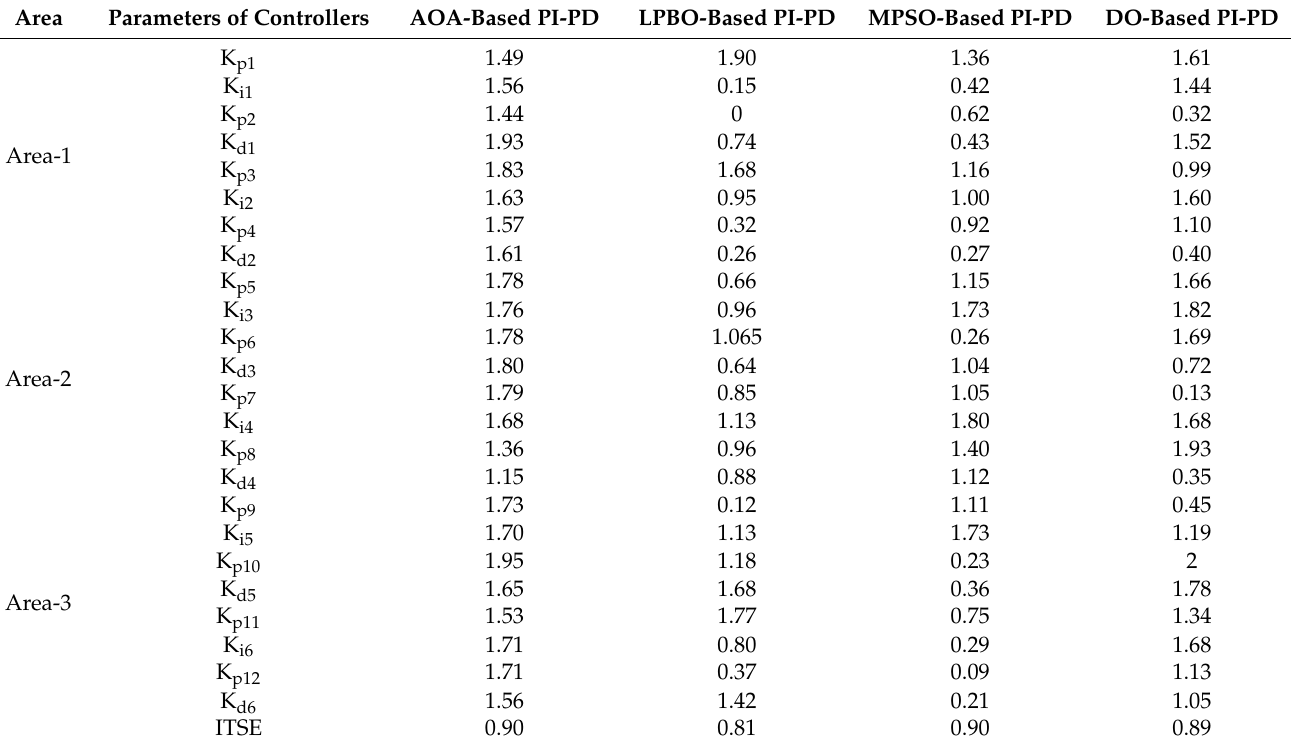
Figure 15. Three-area IPS with combined LFC-AVR. ( a ) Area-1; ( b ) Area-2; ( c ) Area-3. Table 12. Optimal values of controller parameters in a three-area multi-source IPS with nonlinearities.